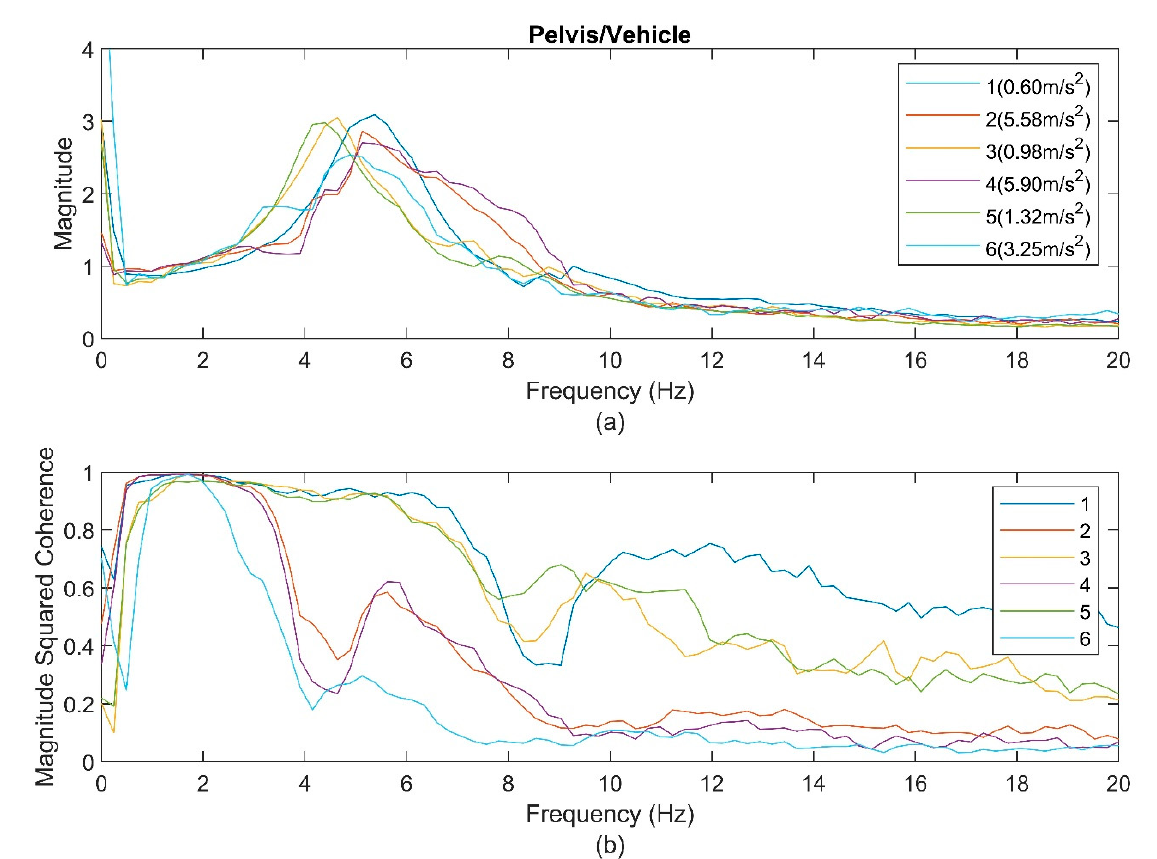
Figure 4. ( a )The transmissibility of the vertical acceleration of the pelvis relative to the vehicle floor for Sections 1–6; the corresponding RMS values of the vertical acceleration for each section are provided in parentheses beside the legends, and ( b ) the corresponding squared coherence graphs.